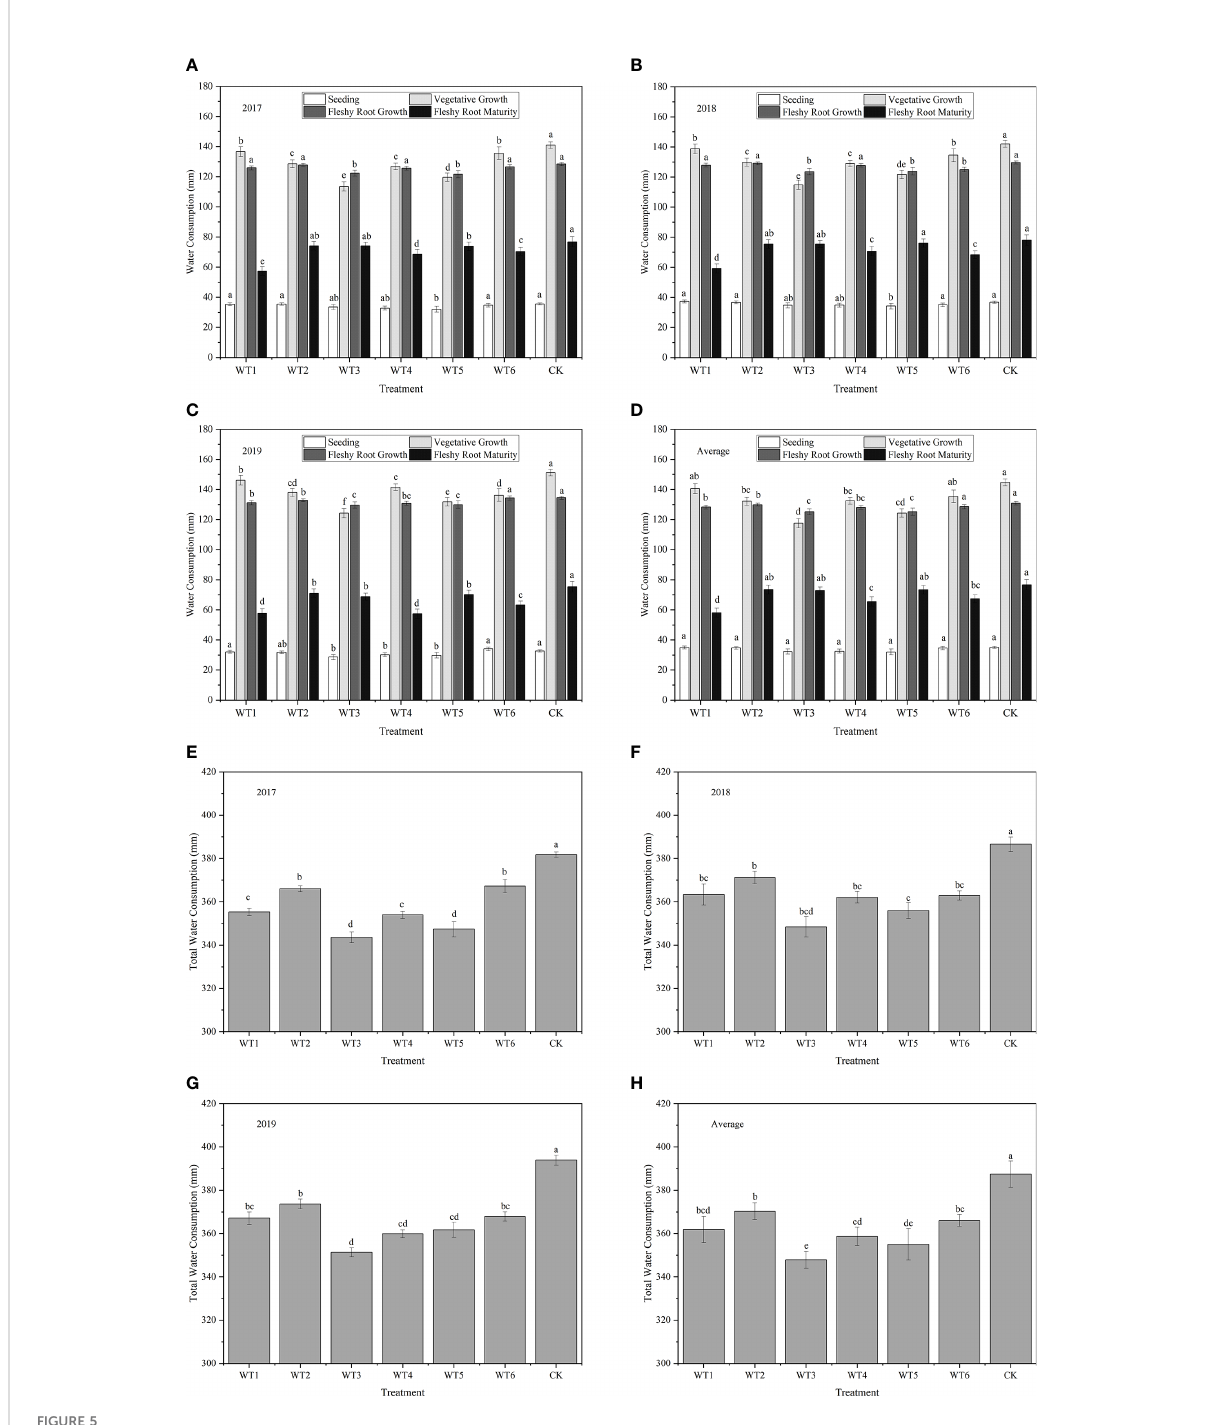
FIGURE 5 Water consumption and total water consumption of I. indigotica plants in different treatments. (A – D) describe the water consumption in 2017, 2018, 2019, and the average of these three years, respectively, while (E – H) describe the total water consumption in 2017, 2018, 2019, and the average of these three years, respectively. Different lowercase letters in the same column indicate signi fi cant differences ( P < 0.05). Data were presented as mean ± SE (n =